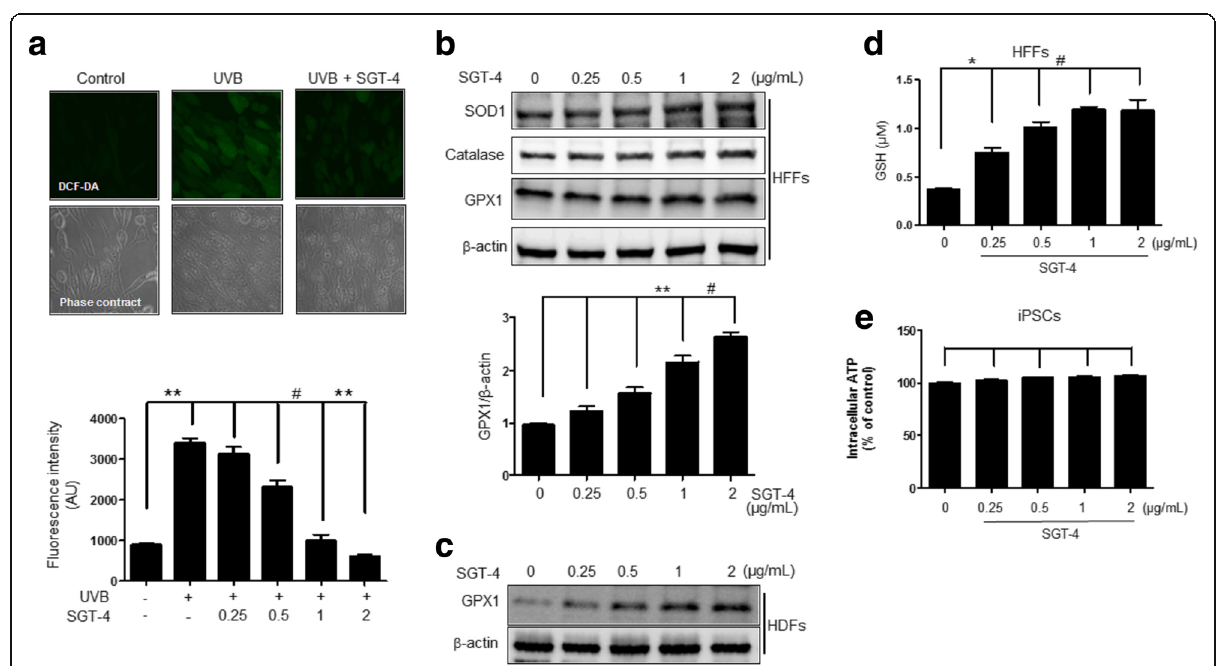
Fig. 5 SGT-4 blocks UVB-induced ROS generation by activating antioxidant enzymes. a Cells were incubated with indicated concentration of SGT- 4 for 24 h and then washed with PBS. The cells were then exposed to a UVB (100 mJ/cm 2 ) light source for 20 min, and stained with DCF-DA for 10 min. Intracellular ROS production was analyzed using confocal microscopy. b HFFs were treated with various doses of SGT-4 for 18 h to determine the expression levels of SOD1, catalase, and GPX1 using Western blot analysis. c Human dermal fibroblasts (HDFs) were treated with various doses of SGT-4 for 18 h to determine the expression levels of GPX1 using Western blot analysis ( d ) HFFs were treated with indicates doses of SGT-4 for 24 h to determine the expression levels of glutathione (GSH) assay kit. e hiPSCs were incubated with indicated concentration of SGT-4 for 24 h and then